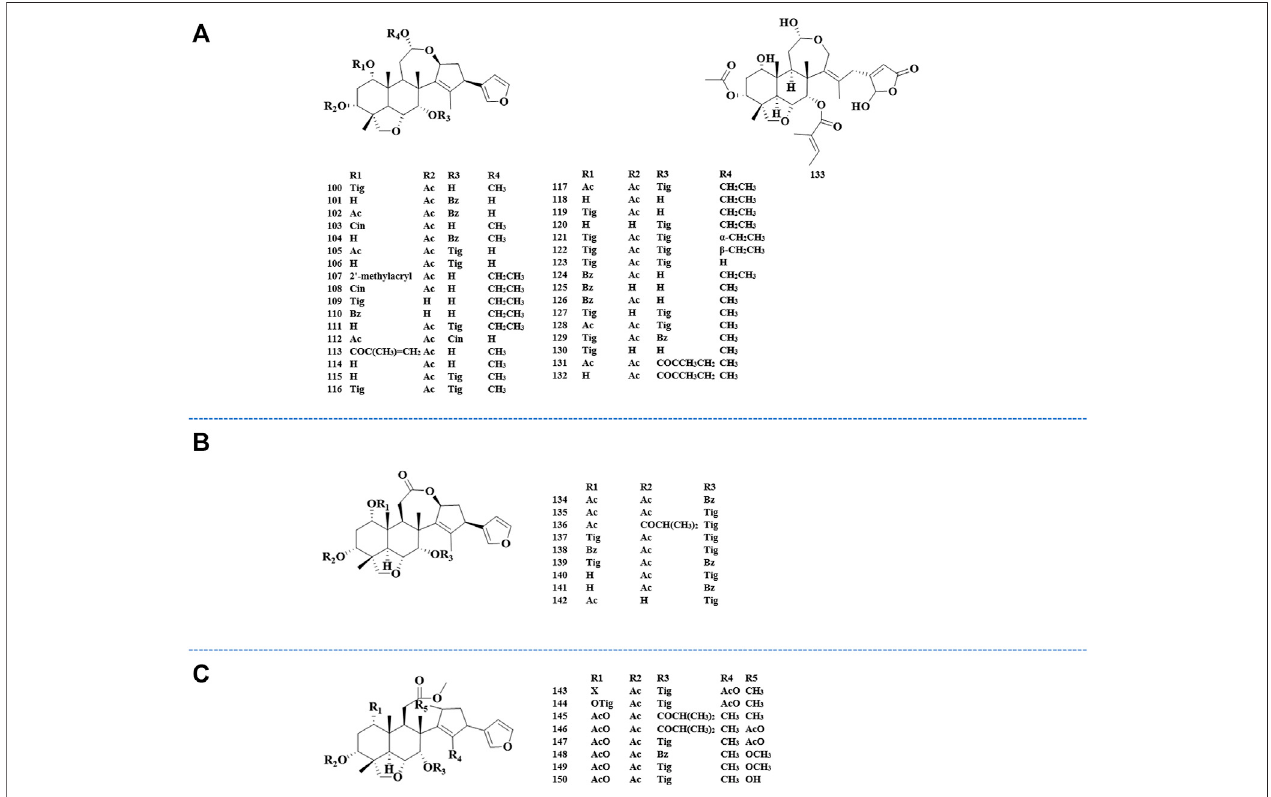
FIGURE 4 | Structures of nimbolinin class limonoids 100 – 133 (A) , structures of ohchinolide class limonoids 134 – 142 (B) , and structures of nimbolidin class limonoids 143 – 150 (C) .